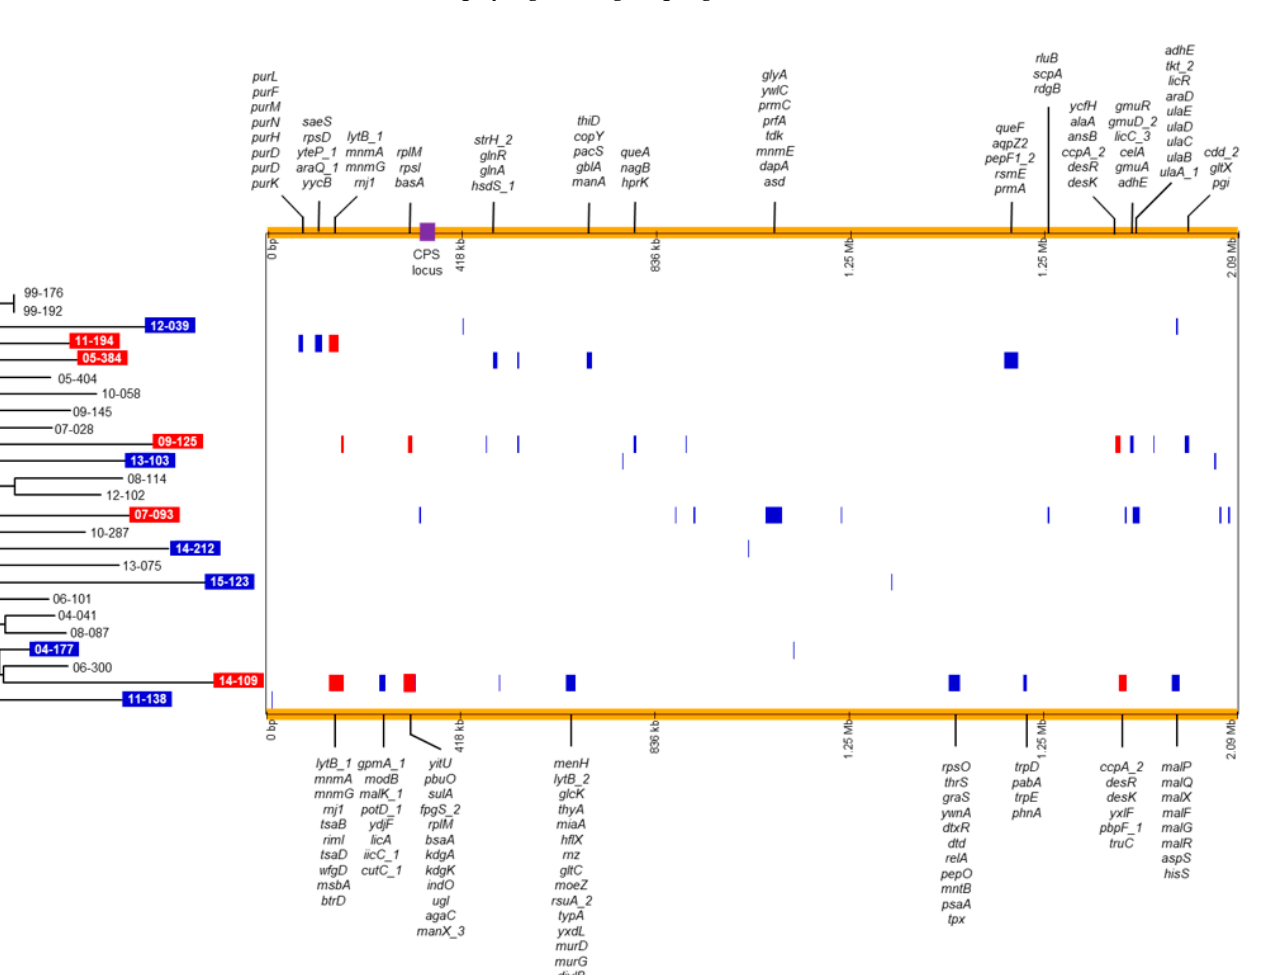
Figure 3. Phylogenetic tree and predicted recombination sites of 25 S. pneumoniae 19A-ST320 isolates analyzed in this study. The phylogenetic tree constructed via RAxML based on SNPs is shown on the left. The isolates showing the pre- dicted recombination events are indicated with a colored background; red background indicates that the r/m value was 10 or more; blue background indicates that the r/m value was <1. A horizontal and colored bar showing the predicted recombination events is displayed for each isolate on the right. Recombination blocks predicted in multiple isolates are presented in a red color and those predicted in one isolate are presented in blue. The genes within recombination blocks including multiple genes are shown at the top and bottom of the figure. The location of the CPS locus is indicated by a purple box. RAxML, Randomized Axelerated Maximum Likelihood; SNPs, single nucleotide polymorphisms; CPS, capsular polysaccharide. 4. Discussion To examine the temporal genetic changes in penicillin-non-susceptible S. pneumoniae 19A-ST320 isolates, which have spread worldwide including to South Korea after the in- troduction of PCV7, we performed WGS for two randomly selected isolates per year from a hospital in South Korea. Despite the fact that these isolates were obtained from a single hospital and all showed the same serotype and genotype, the degree of genetic variation was much larger than expected. By performing a phylogenetic analysis based on SNPs, we found that the isolates from South Korea did not form one or a few clades among the S. pneumoniae 19A-ST320 isolates from several continents. However, certain pneumococcal isolates from South Korea such as 06-300 and 19-019 were clustered with the isolates from China; several isolates were dispersed in the phylogenetic tree. This suggested that all 19A-ST320 iso- lates, whose incidence increased after the introduction of PCV7, did not disseminate in South Korea via clonal spreading. Instead, the 19A-ST320 pneumococcal isolates from